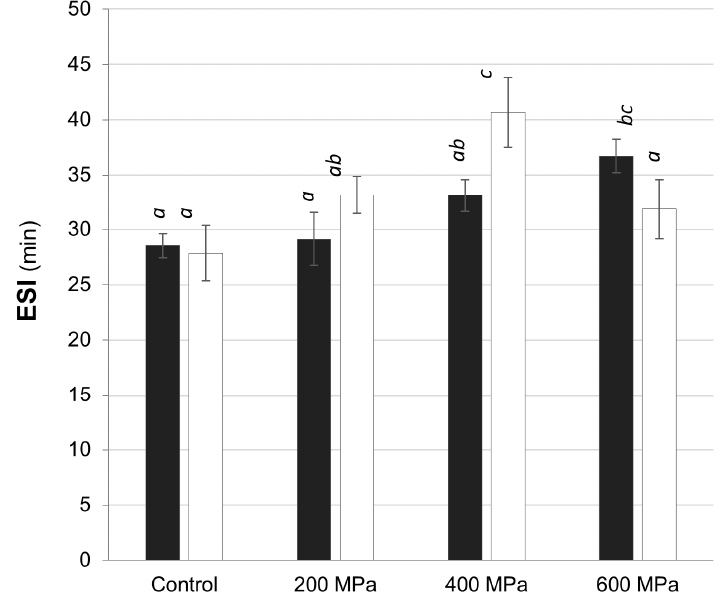
Figure 5. Emulsifying stability index (ESI) measured for O/W emulsions prepared with pea (total fraction—filled columns; soluble fraction—blank columns) protein dispersions (pH 7) previously subjected to different HPP treatments (200, 400 and 600 MPa for 15 min). Different letters indicate significant differences ( p < 0.05) between samples; vertical bars denote the standard deviation from three replicates.